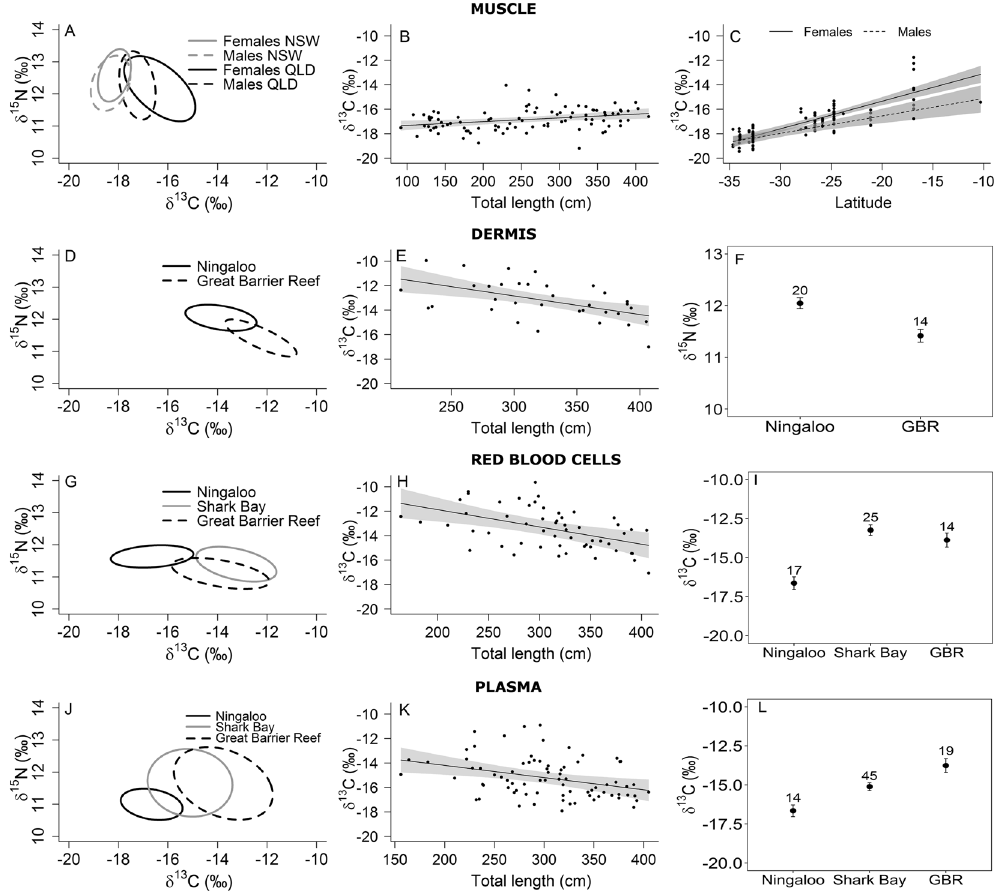
Figure 4. Muscle ( A–C ), dermis ( D–F ), red blood cells ( G–I ) and plasma ( J–L ). Standard ellipse areas for analysis of tissues corrected for sample size (SEAc) ( A,D,G,J ). Partial dependence plots of the relationship between δ 13 C and the explanatory variables in the top-ranked model, total length ( B,E,H,K ), the interaction between latitude and sex ( D ) and location ( F,I,L ). Points represent partial residuals and shaded areas show the 95% confidence intervals.